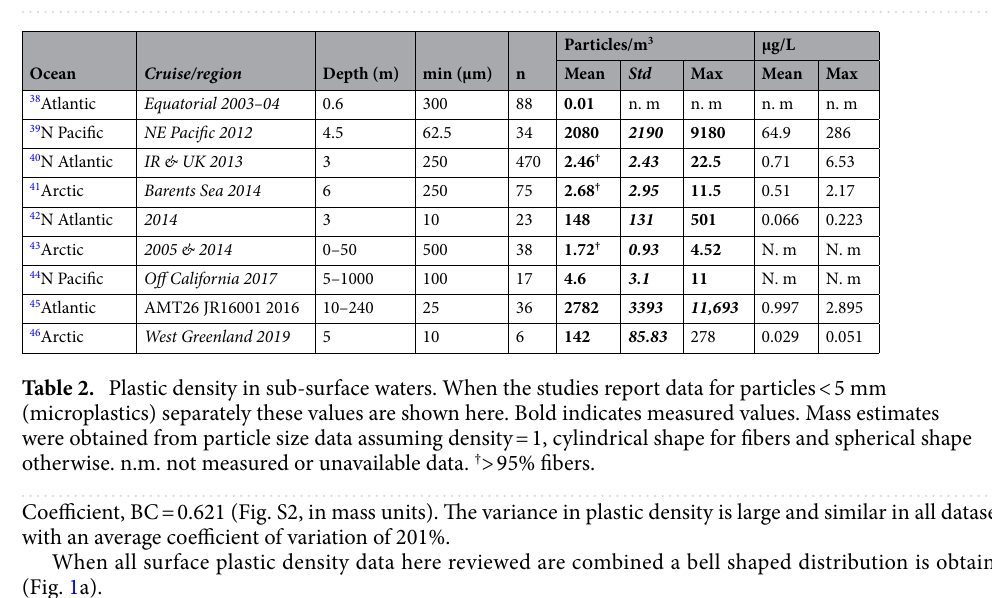
Table 1. Plastic density in surface waters; studies for which data from individual trawls were available. When data are reported per sea surface area only sampled volume was calculated from the area of the sampling device trawled inside the water. n, sample size; Std/CV, standard deviation/Coefficient of variation; and n.m.,not measured or unavailable data. *Zero values excluded.